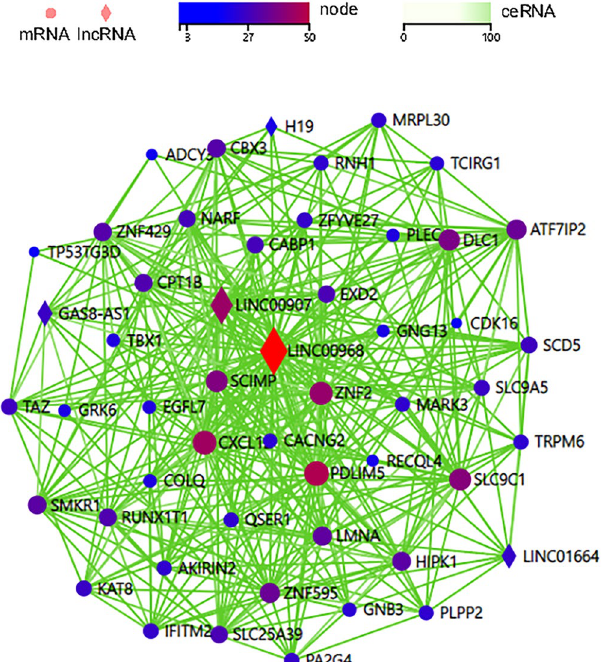
Figure 4. The Competing endogenous RNA network of LINC00968. The diamonds represent lncRNAs, and the circles represent mRNAs. From dark blue to deep red indicates more nodes between lncRNA-mRNA. The green line indicates an endogenous competitive relationship.